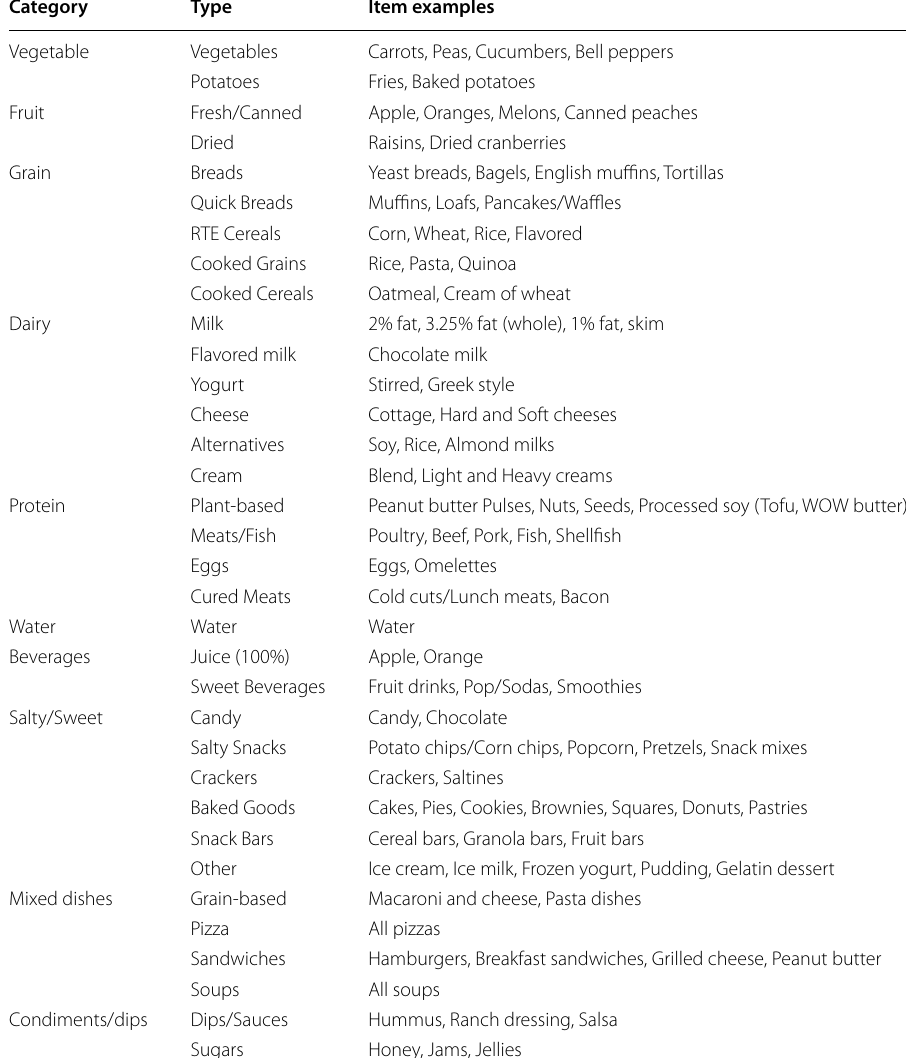
Table 1 Food categorization adapted from what we eat in America (WWEIA) (USDA ARS, 2018)